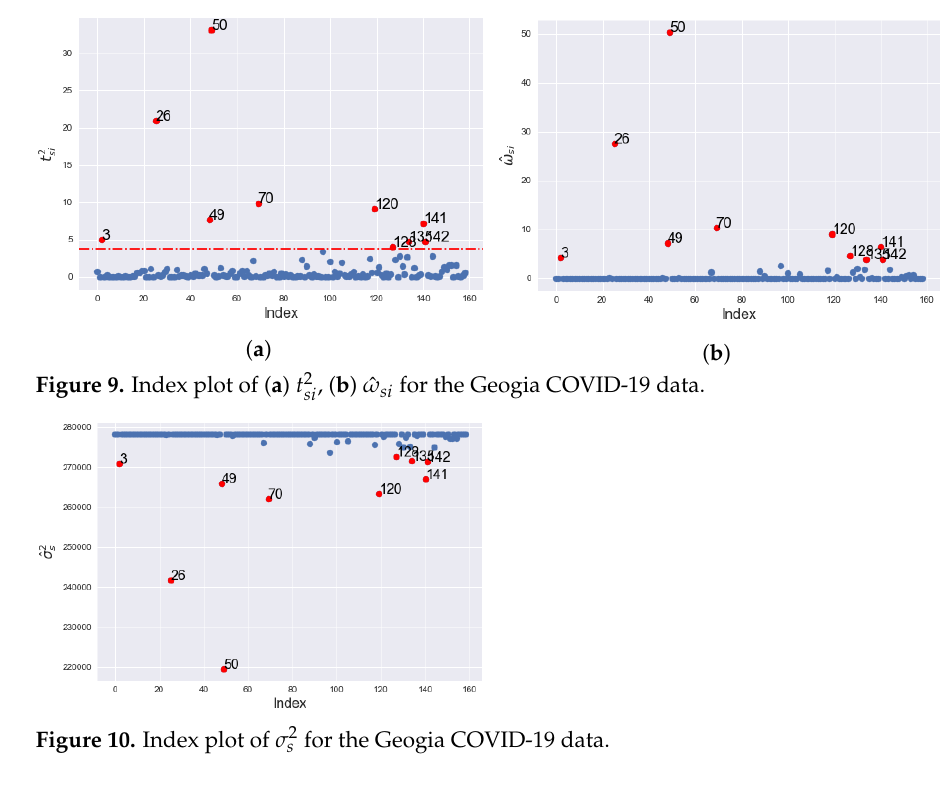
The index plot of the squared spatial studentized residuals in Figure 9a shows the counties detected as outliers, having large t 2 . Similarly, the index plot of the ˆ ω si in Figure 9b si shows the classified counties with the largest weights and, hence, inflation in the variance. The RSDP correctly classified counties with serial number 3, 26, 49, 50, 70, 120, 128, 135, 141 and 142, respectively. Figure 9a shows the serial numbers of the counties with inflated variance that are greater than the threshold value of 3.73. Similarly, Figures 9b and 10 show the indices of locations with largest weight ( ˆ ω si ) and that with inflation in variance ( ˆ σ 2 ), respectively. s